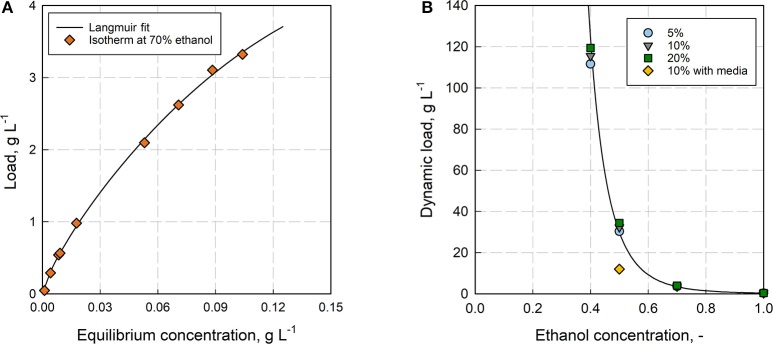
(A) Adsorption isotherm for β-caryophyllene on Rensa® RP at 70% ethanol determined with the frontal analysis (FA). (B) Dependence of the Dynamic Binding Capacity (DBC) subject to the ethanol concentration for β-caryophyllene on Rensa® RP. Shown are the capacities for the breakthrough at 5, 10, and 20% (relatively to the initial concentration; Column volume = 0.46 mL, flow rate = 2.9 cm min−1, HETP = 0.02 cm).